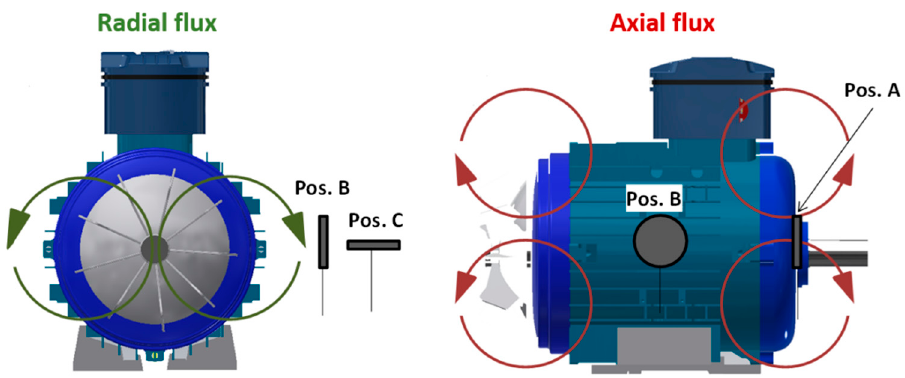
Figure 3. Nature of the flux captured at each coil sensor position [36,39].